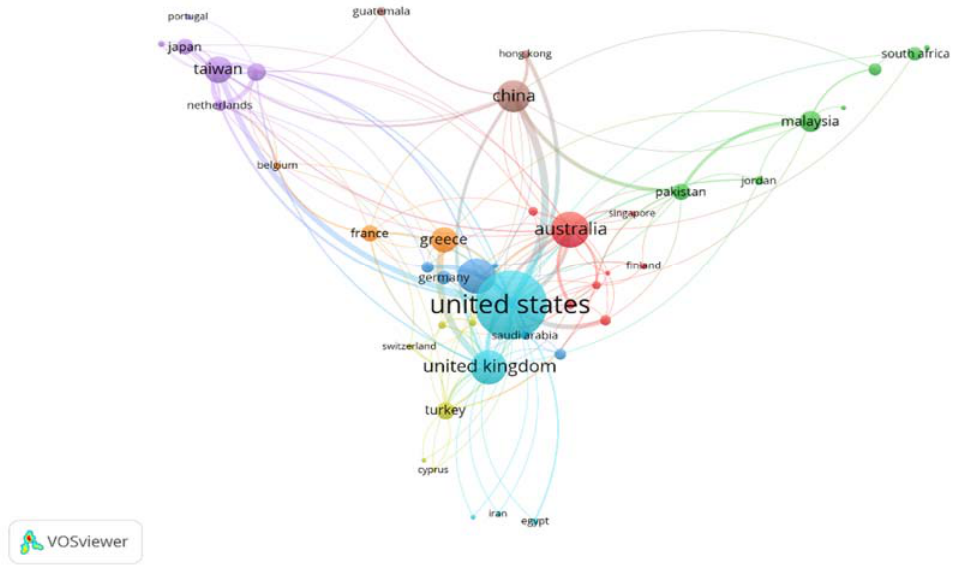
Figure 5. Network visualisation of country collaborations. Source: Elaborated by authors using data extracted from Scopus.